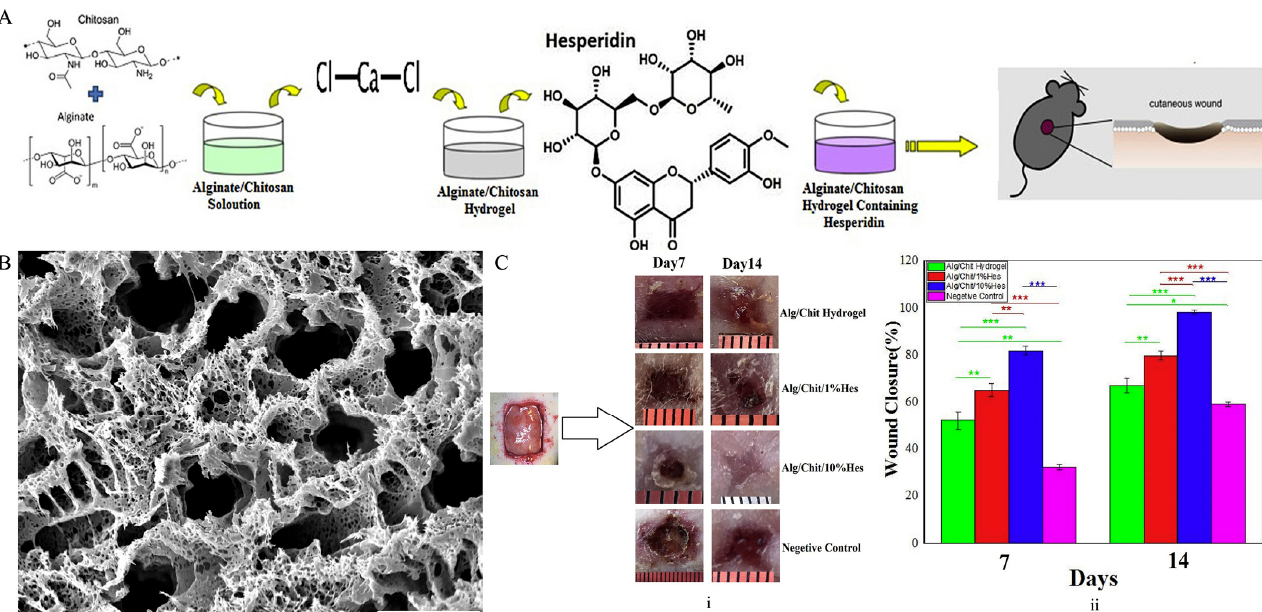
Figure 6. Wound repair with hesperidin-containing alginate/chitosan hydrogel. ( A ) Schematical representation of alginate/chitosan hydrogel preparation. ( B ) Alg/Chit/1%Hes under the SEM (Scale Bar: 100 μ m). ( C ) (i) Wound morphology at 7 and 14 days after injury. (ii) Healing process at 7 and 14 days after injury. Values represent the mean ± SD, n = 6, * p < 0.05, ** p < 0.01, and *** p < 0.001. SD: standard deviation. Reprinted with permission from [122], copyright 2020 Elsevier.